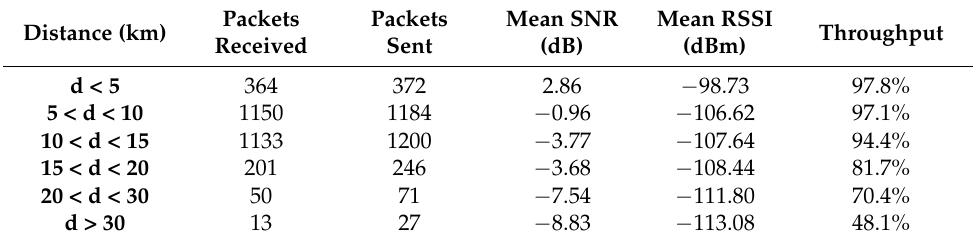
Table 2. Radio channel ranging survey